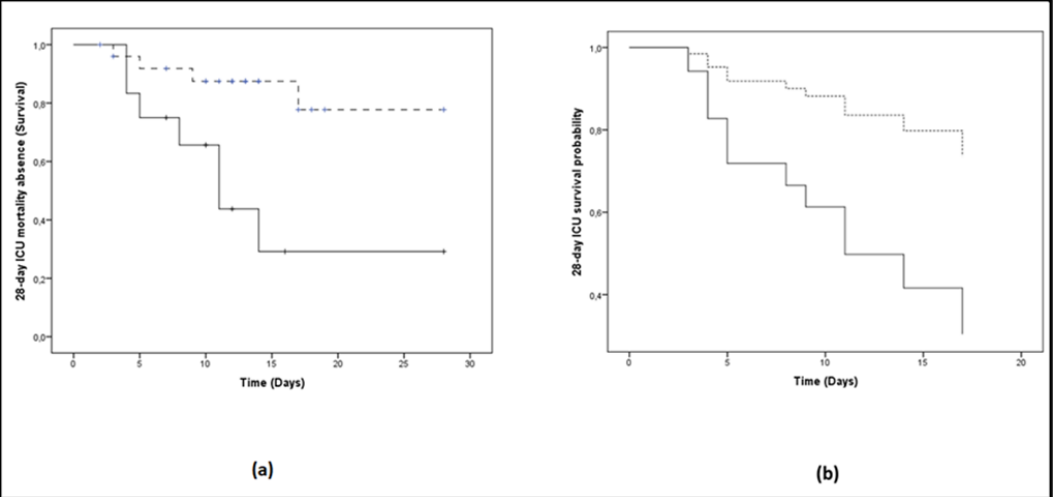
Figure 2. Lactate levels on ICU admission and 28-day mortality probability. The patient cohort was dichotomized above and below the best lactate prognostic discriminating value. Solid lines: ≥ 1.85 mmol / L; dashed lines: < 1.85 mmol / L. ( a ) The Kaplan–Meier method was used for 28-day ICU mortality absence probability estimation and the log-rank test for comparison of the two groups. The respective mean time to 28-day ICU mortality was 14.4 days (95% CI: 8.5–20.3) for the high lactate group, whereas for the low lactate group it was 24.1 days (95% CI: 20.7–27.6) (log-rank test, p = 0.005); ( b ) The corresponding Cox proportional hazards regression model also showed a significant difference in survival with lactate over (solid line) or under (dashed line) the cut-off of 1.85 mmol / L (RR: 0.257 (0.077–0.857), p = 0.027). Lactate measurements of days 1 and 2 were combined because admission to the ICU occurred mostly in late